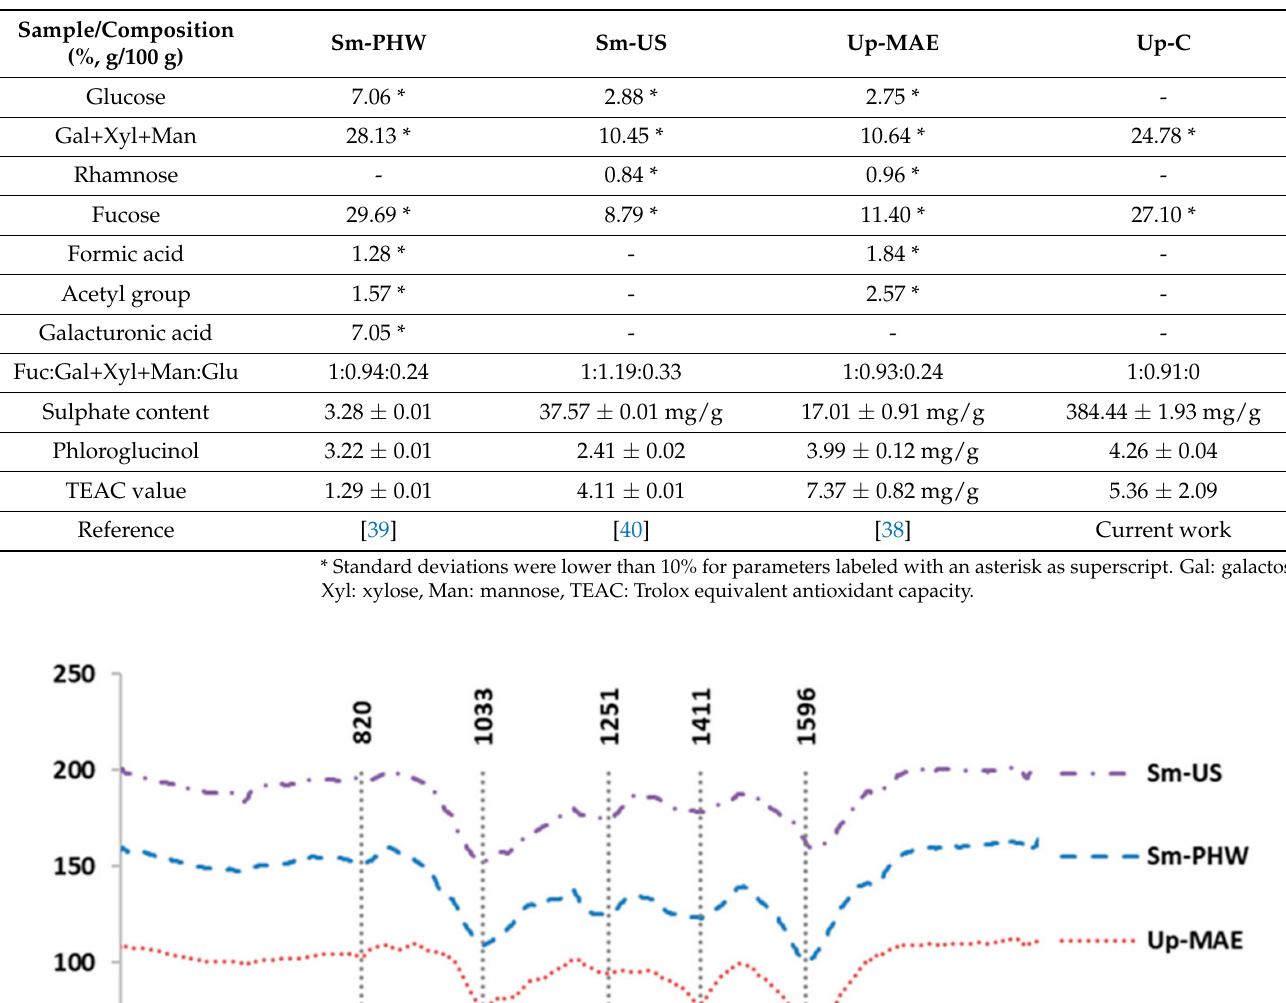
Table 1. Fundamental composition of crude fucoidans tested in this work.